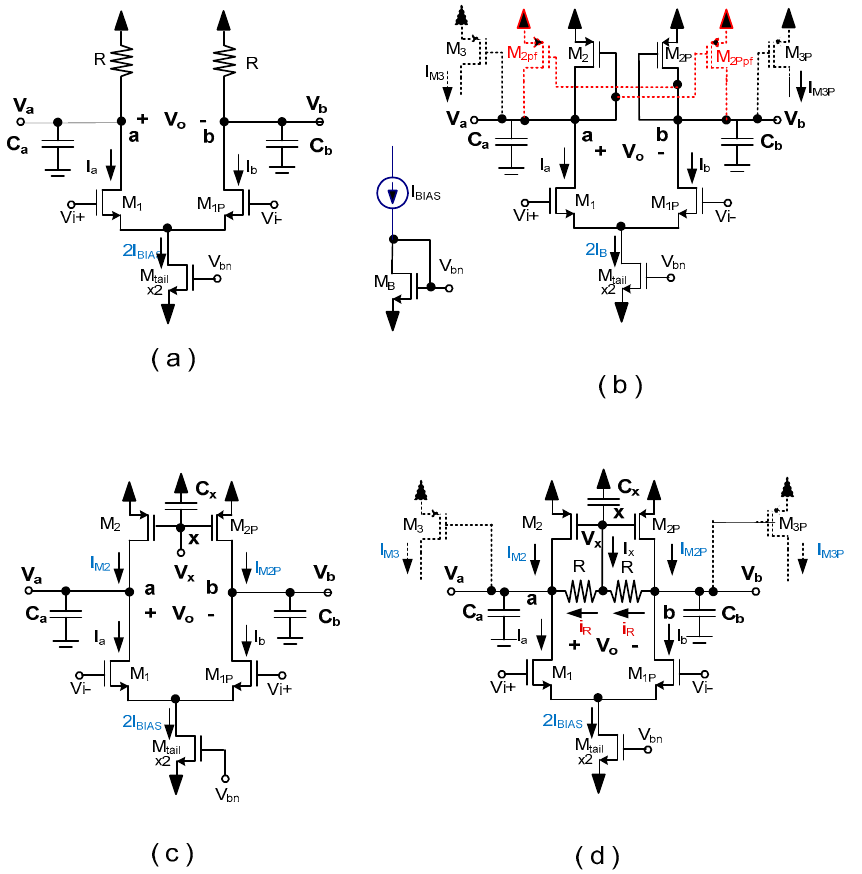
Figure 1. ( a ) Conventional differential pair with resistive load. ( b ) Differential pair with diode-connected load and optional positive feedback load ( c ) Differential pair with current source active loads ( d ) Differential pair with resistive local common mode feedback load. This is a figure. Schemes follow the same formatting.